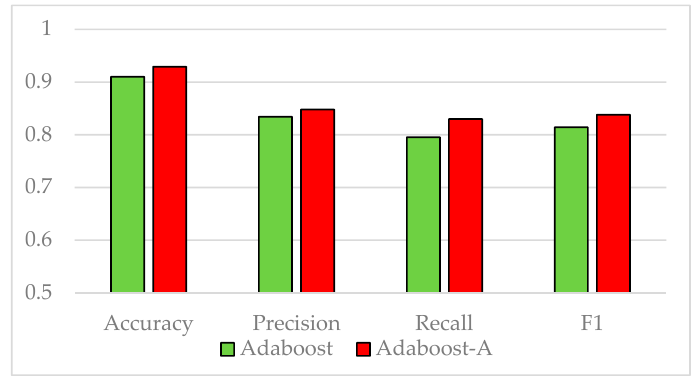
Figure 2. Performance Comparison on Vehicle Test Set.